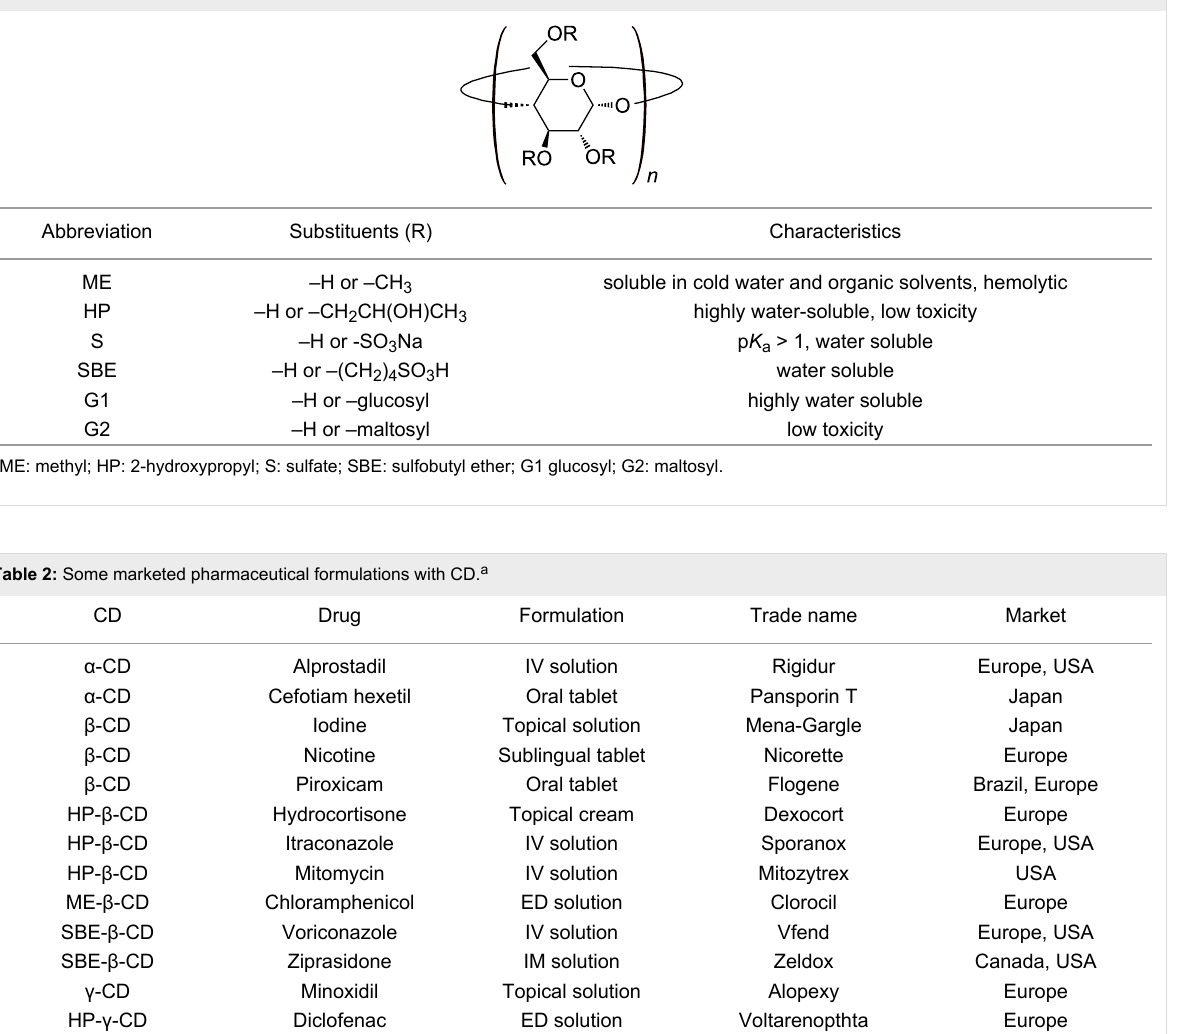
Table 1: Structures, acronyms and characteristics of some modified cyclodextrins. a